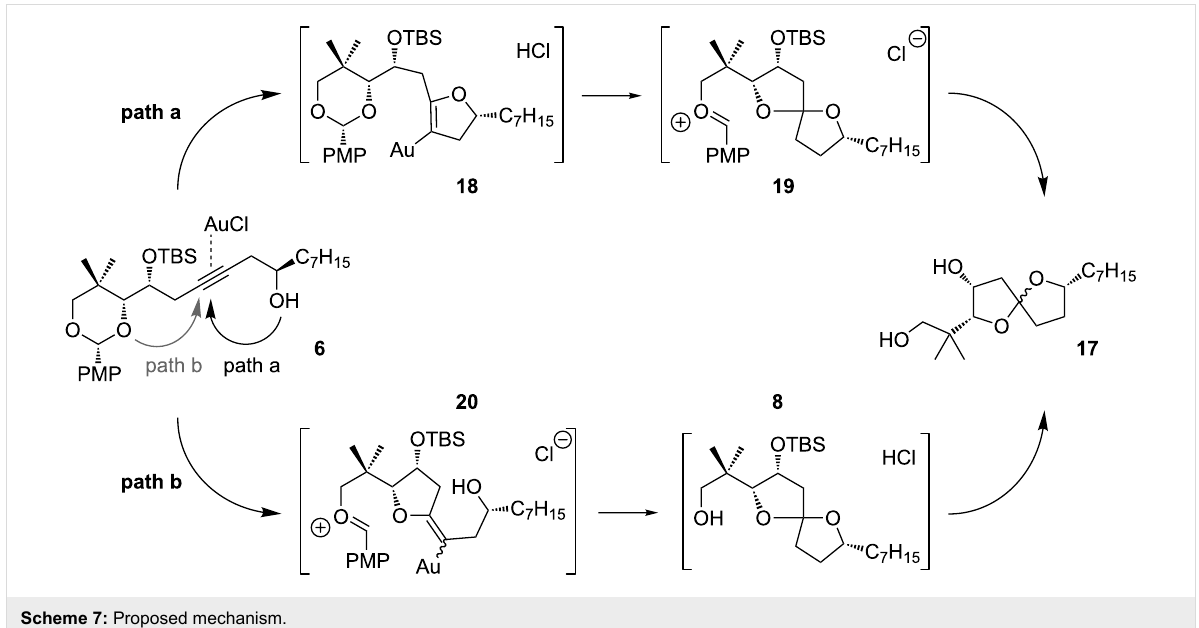
Scheme 7: Proposed